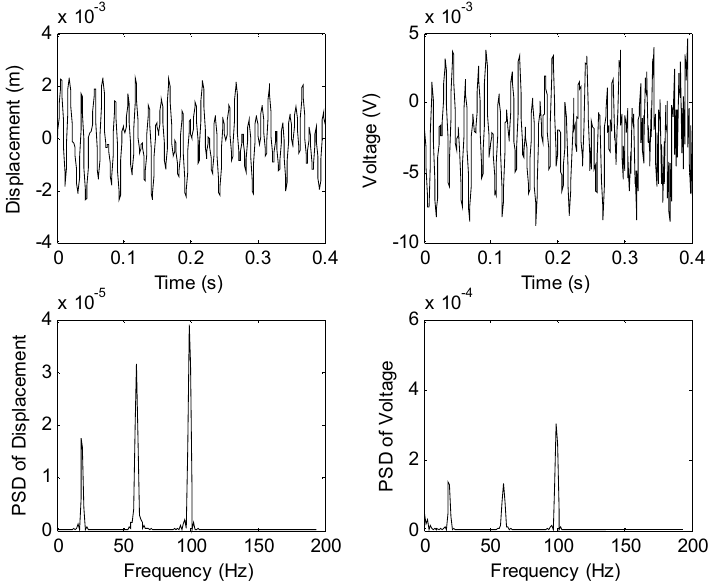
Fig. 22. Steady-state time history and frequency spectrum plots for vertical blade tip displacement and PZT sensor voltage at f = 20 Hz. Sinusoidal vertical step forces are acting in the middle and at the tip of the blade with respective frequencies of 20 Hz and 100 Hz.